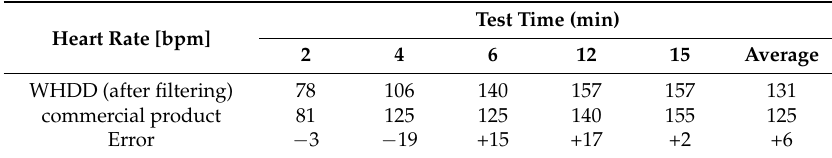
Table 8. Comparison between heart rates measured with the WHDD and with a commercially available heart rate belt during running.